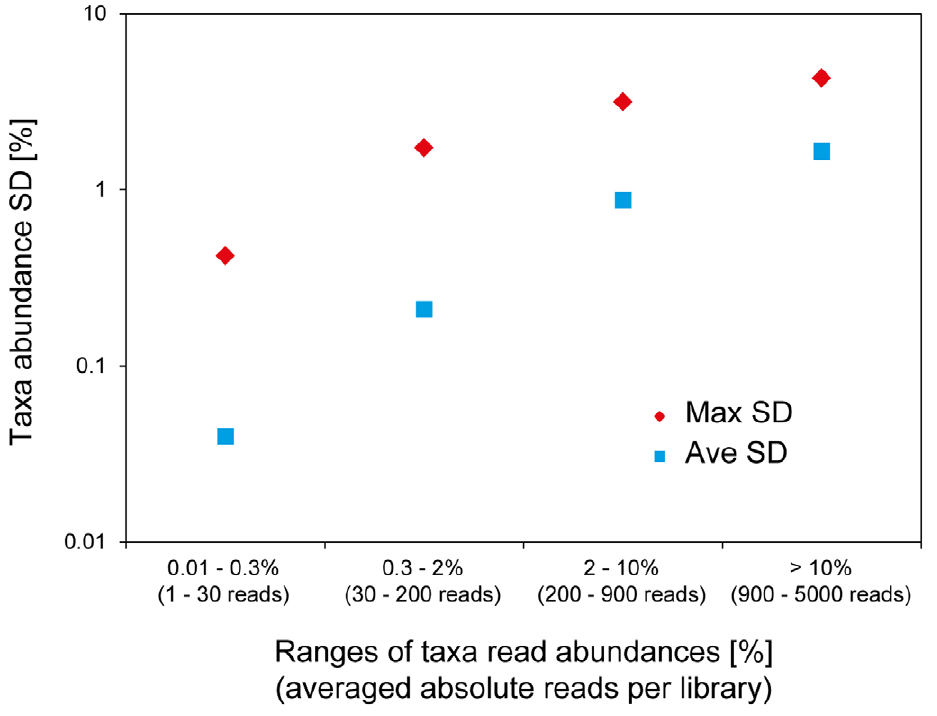
Figure 2. Read abundance standard deviation (SD) for dominating and less abundant taxa in pyrotag libraries. Averaged and maximal SDs for taxa within specified abundance ranges are given. All taxa resolved by the RDP-classifier and recovered at 1 read in average or more over 9 sediment pyrotag libraries were included in the calculation.